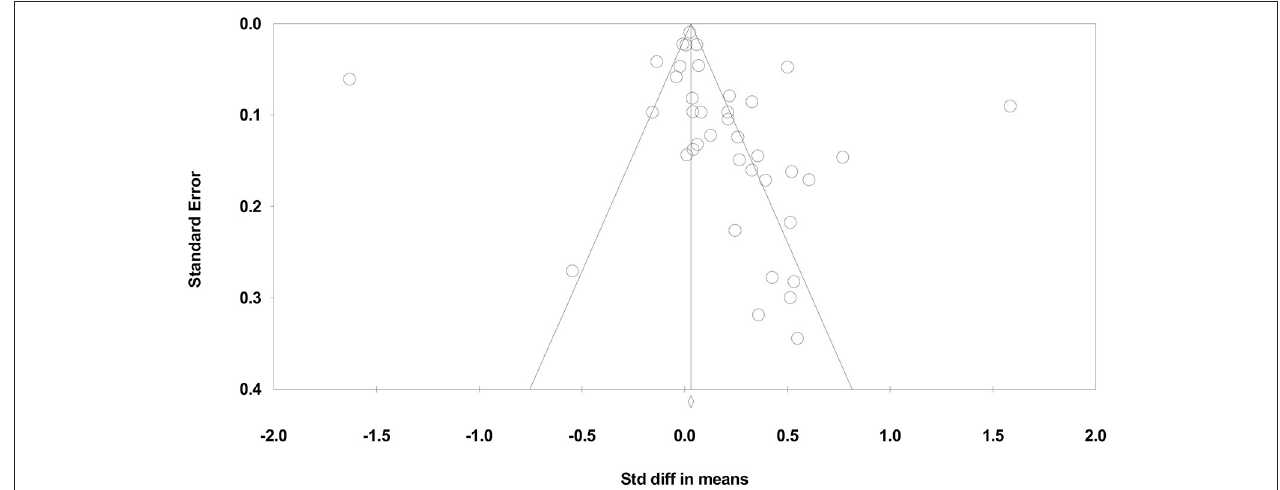
FIGURE 4 | Funnel plot of standard error by standardized difference in means of cognitive PE